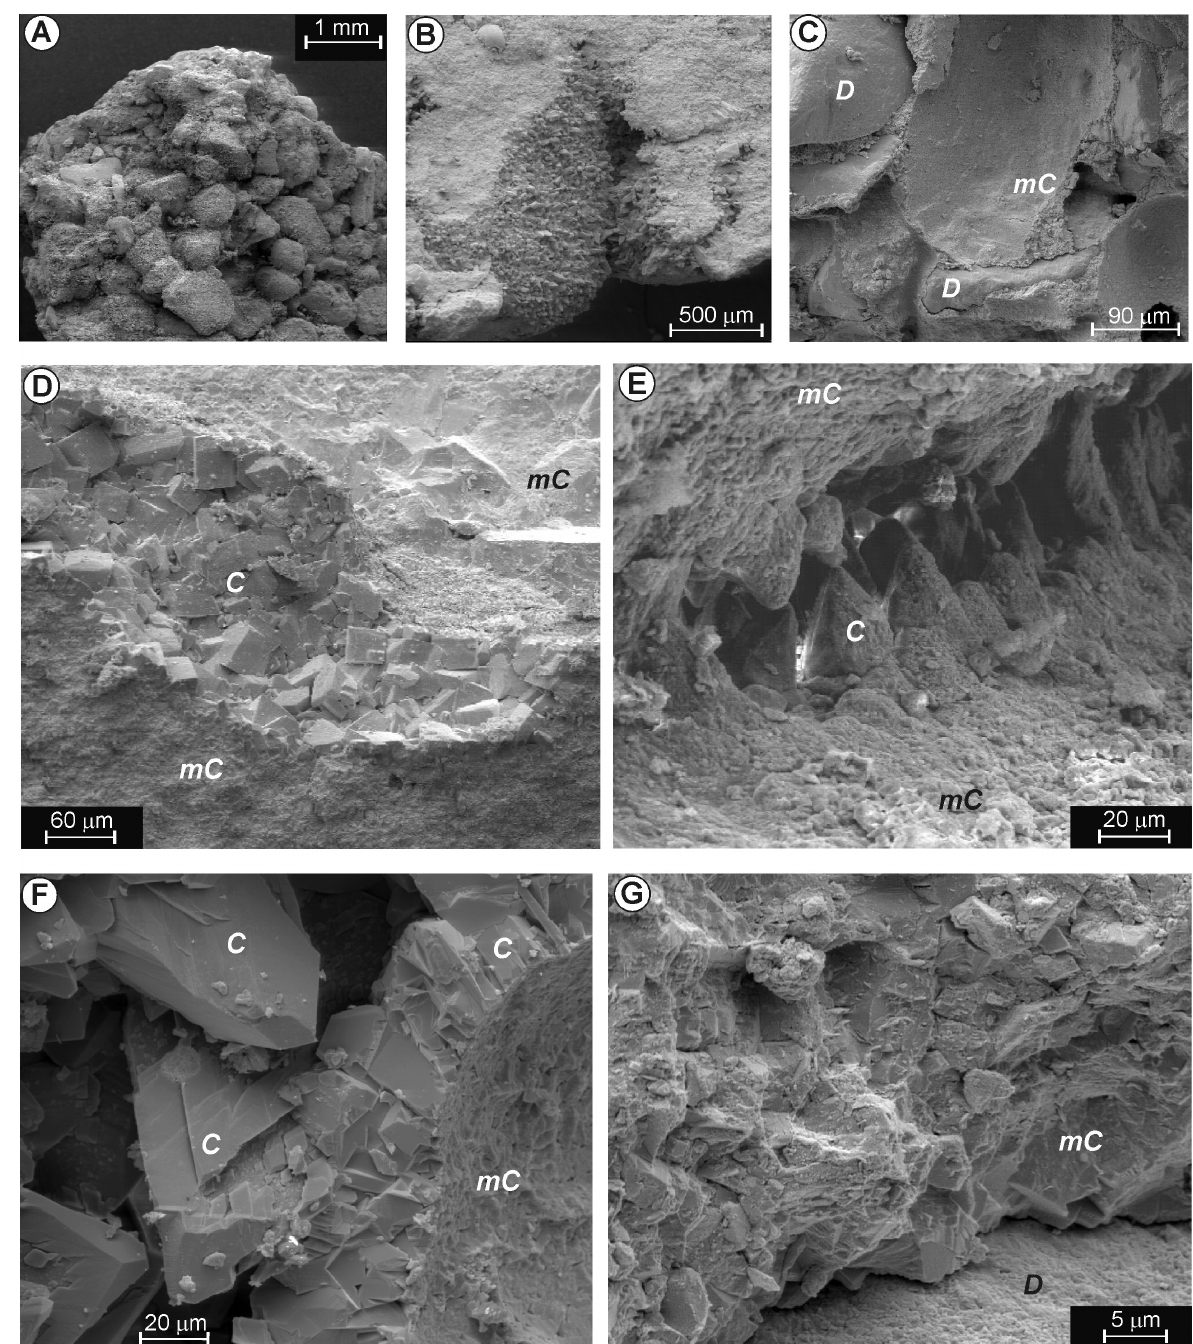
Fig. 7. Micromorphology (SEM images) of calcite cement. A , view of a cemented sand deposit, where a secondary calcite coating covers detrital grains sticking them together; B , detrital grains covered by a coating of elongated calcite crystals, and this in turn by micritic (< 4 (cid:181)m) massive calcite; C , micritic cement between detrital grains; a smooth cement surface had formerly been fringing a detrital grain; D , sparite with equilateral, almost cube-shaped calcite crystals in the subhedral calcite mass with some rhombohedron faces; E , scalenohedral calcite crystals grown perpendicular to grain surfaces towards the intergranular pore space; F , rim of the elongated calcite crystals with sharp tips orientated towards intergranular voids; G , massive micritic cement fringing a detrital quartz grain. See Fig. 6 for